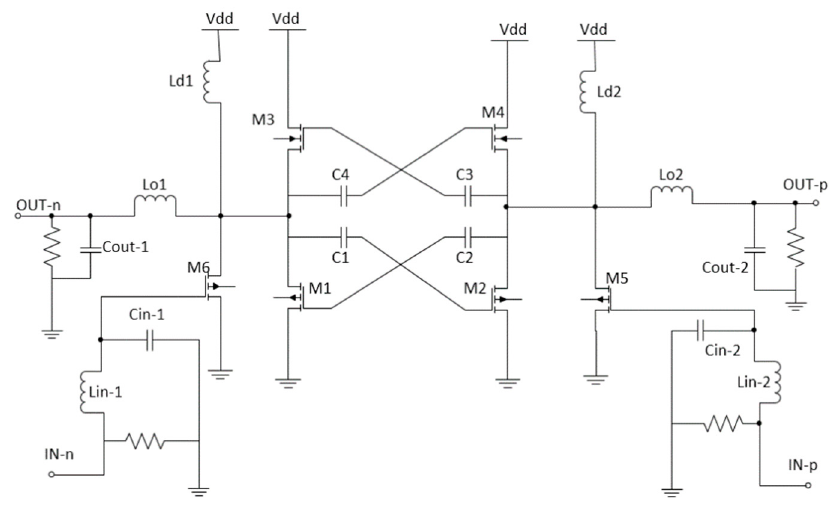
Figure 13. Class-E differential PA with cross-coupling pair [43].